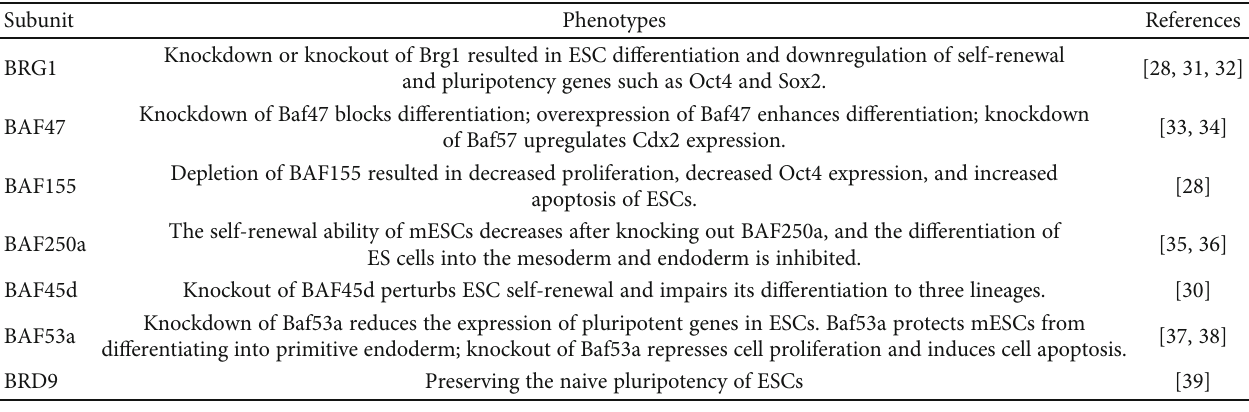
Table 1: The role of BAF subunits in mESCs.